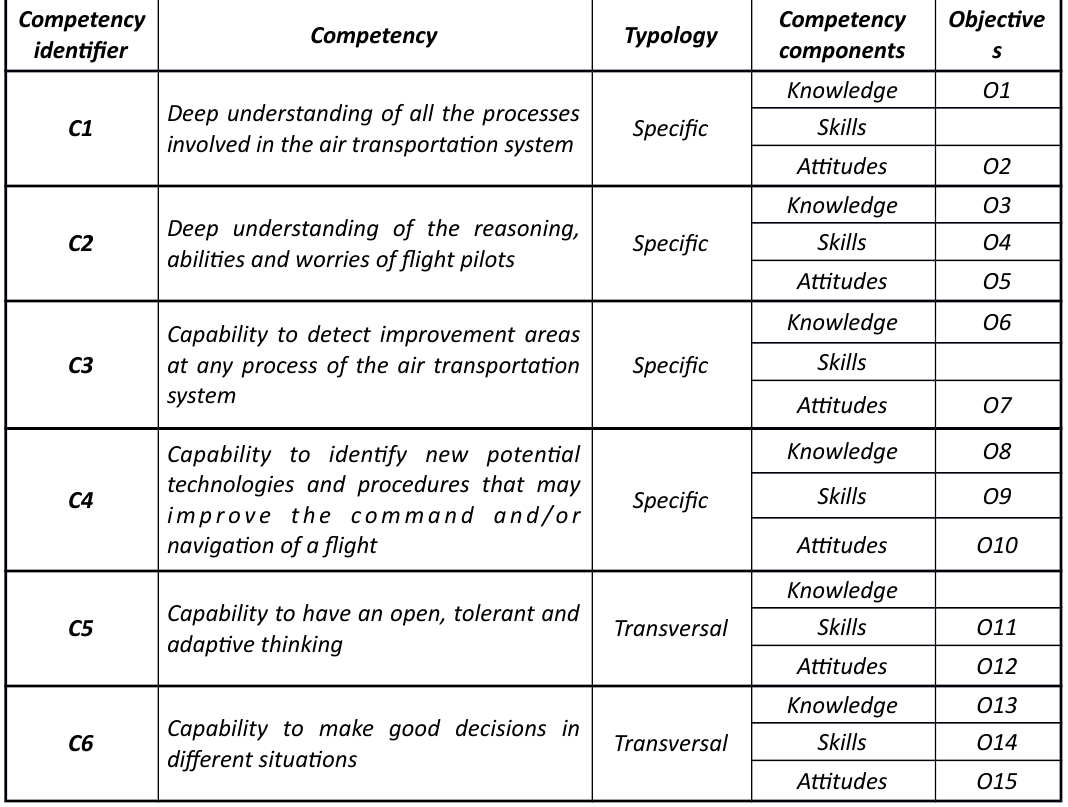
Table 1. Competencies and relatonship with the teaching experience objectves